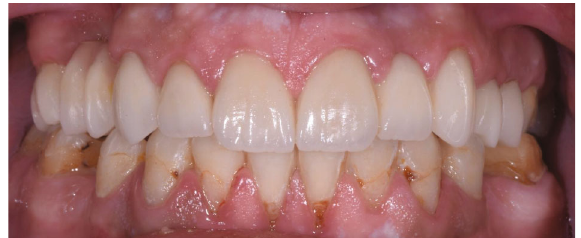
Figure 5: Postoperative intraoral frontal view of the full-coverage restorations illustrating the corrected occlusal relationship.